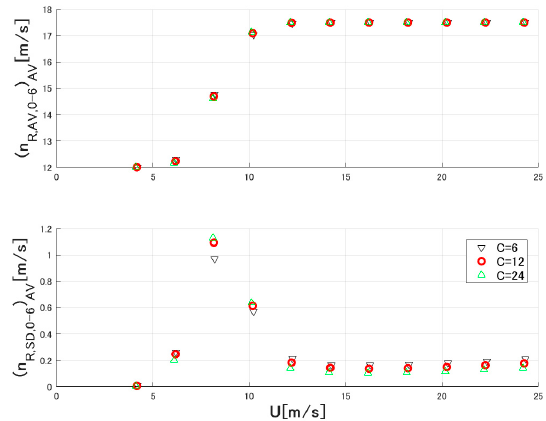
Figure 8. Mean and standard deviation for the rotor speeds of the seven rotors to the average centre hub wind.